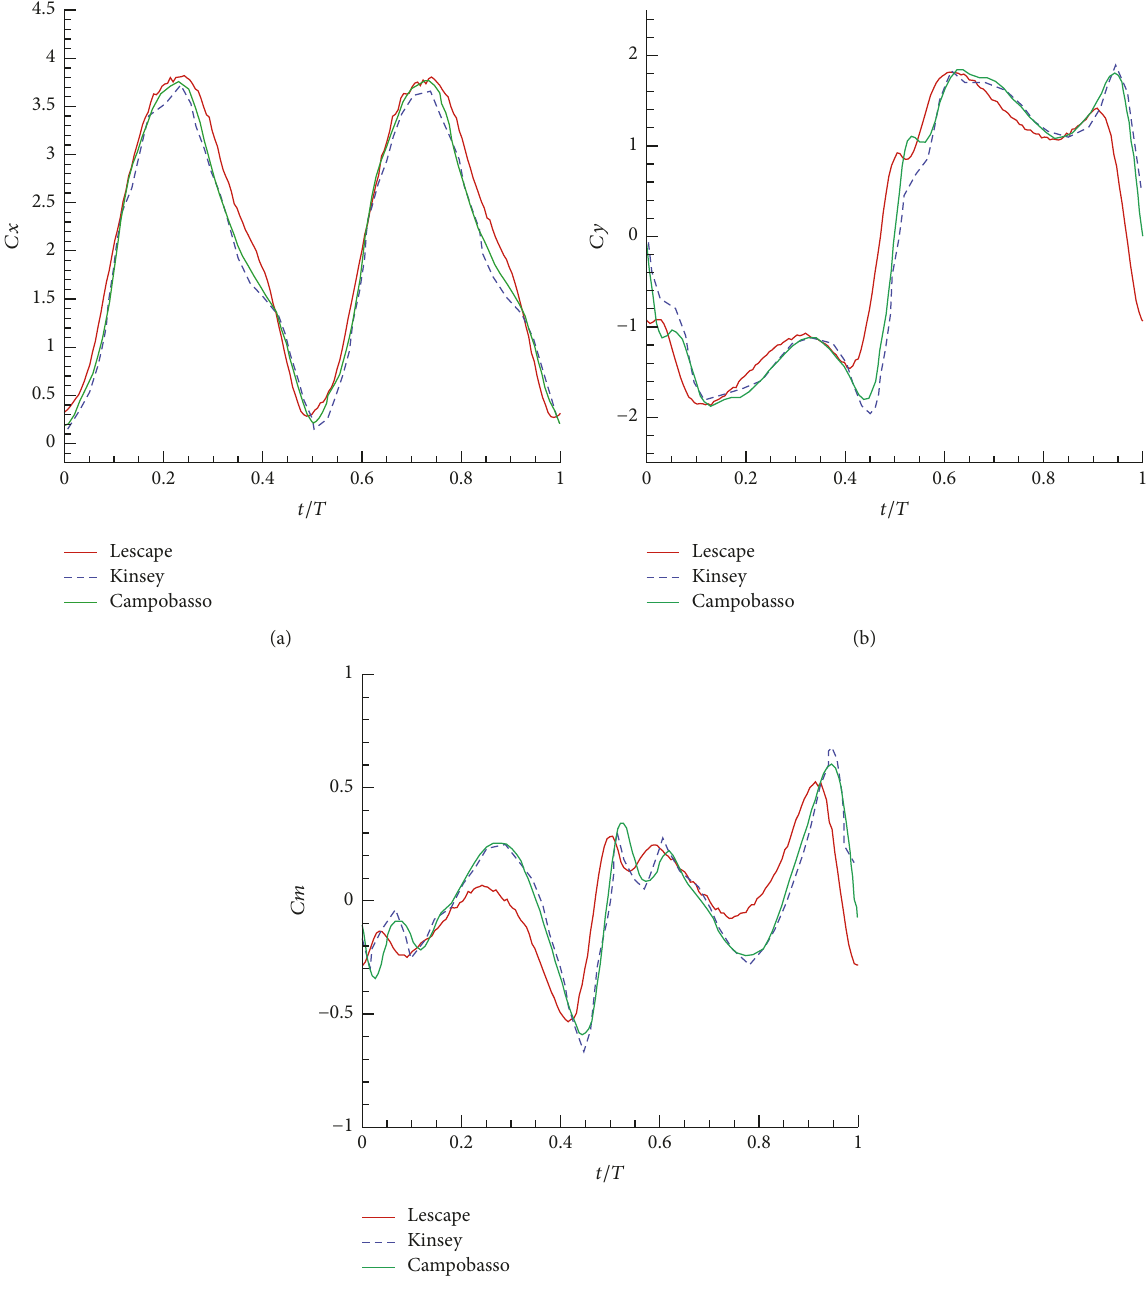
Figure 8: Oscillating airfoil, comparison with the results obtained by [15, 16]. (a) Drag coefficient, (b) lift coefficient, and (c) pitching moment.